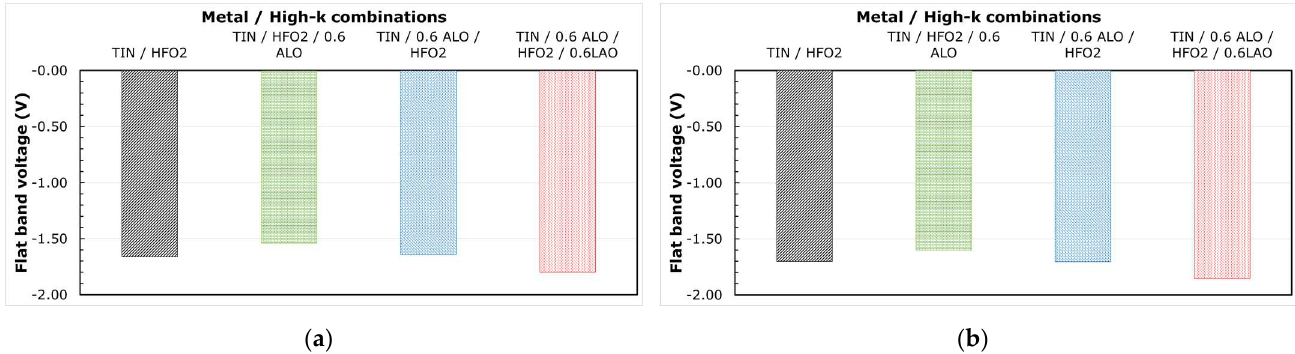
Figure 16. Flat band voltage monitored from CV traces, for MHONOS stacks with different dipole interlayers from Figure 15 ( a ) without any PMA and ( b ) with PMA for 20 min at 750 °C in N 2 ambient.